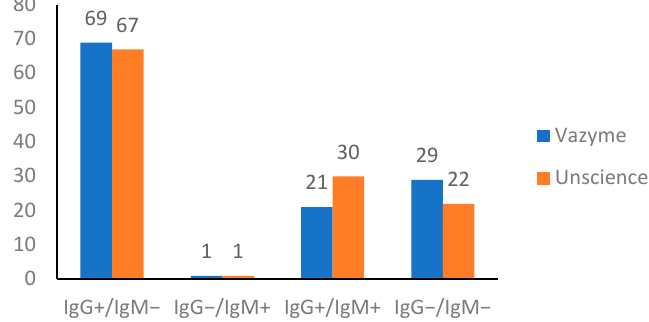
Figure 1. Results of comparison between Vazyme and Unscience.